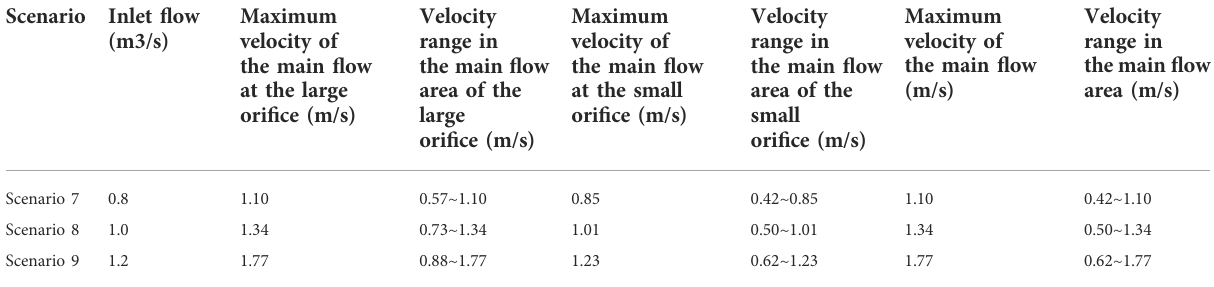
TABLE 7 Calculation results of fl ow rate under different